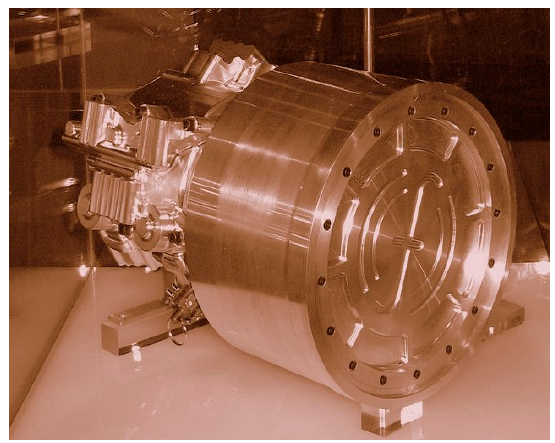
Figure 33. A flywheel used in the Formula One racing kinetic energy recovery system (KERS) . Energies 2017 , 10 , 1217 28 of 82